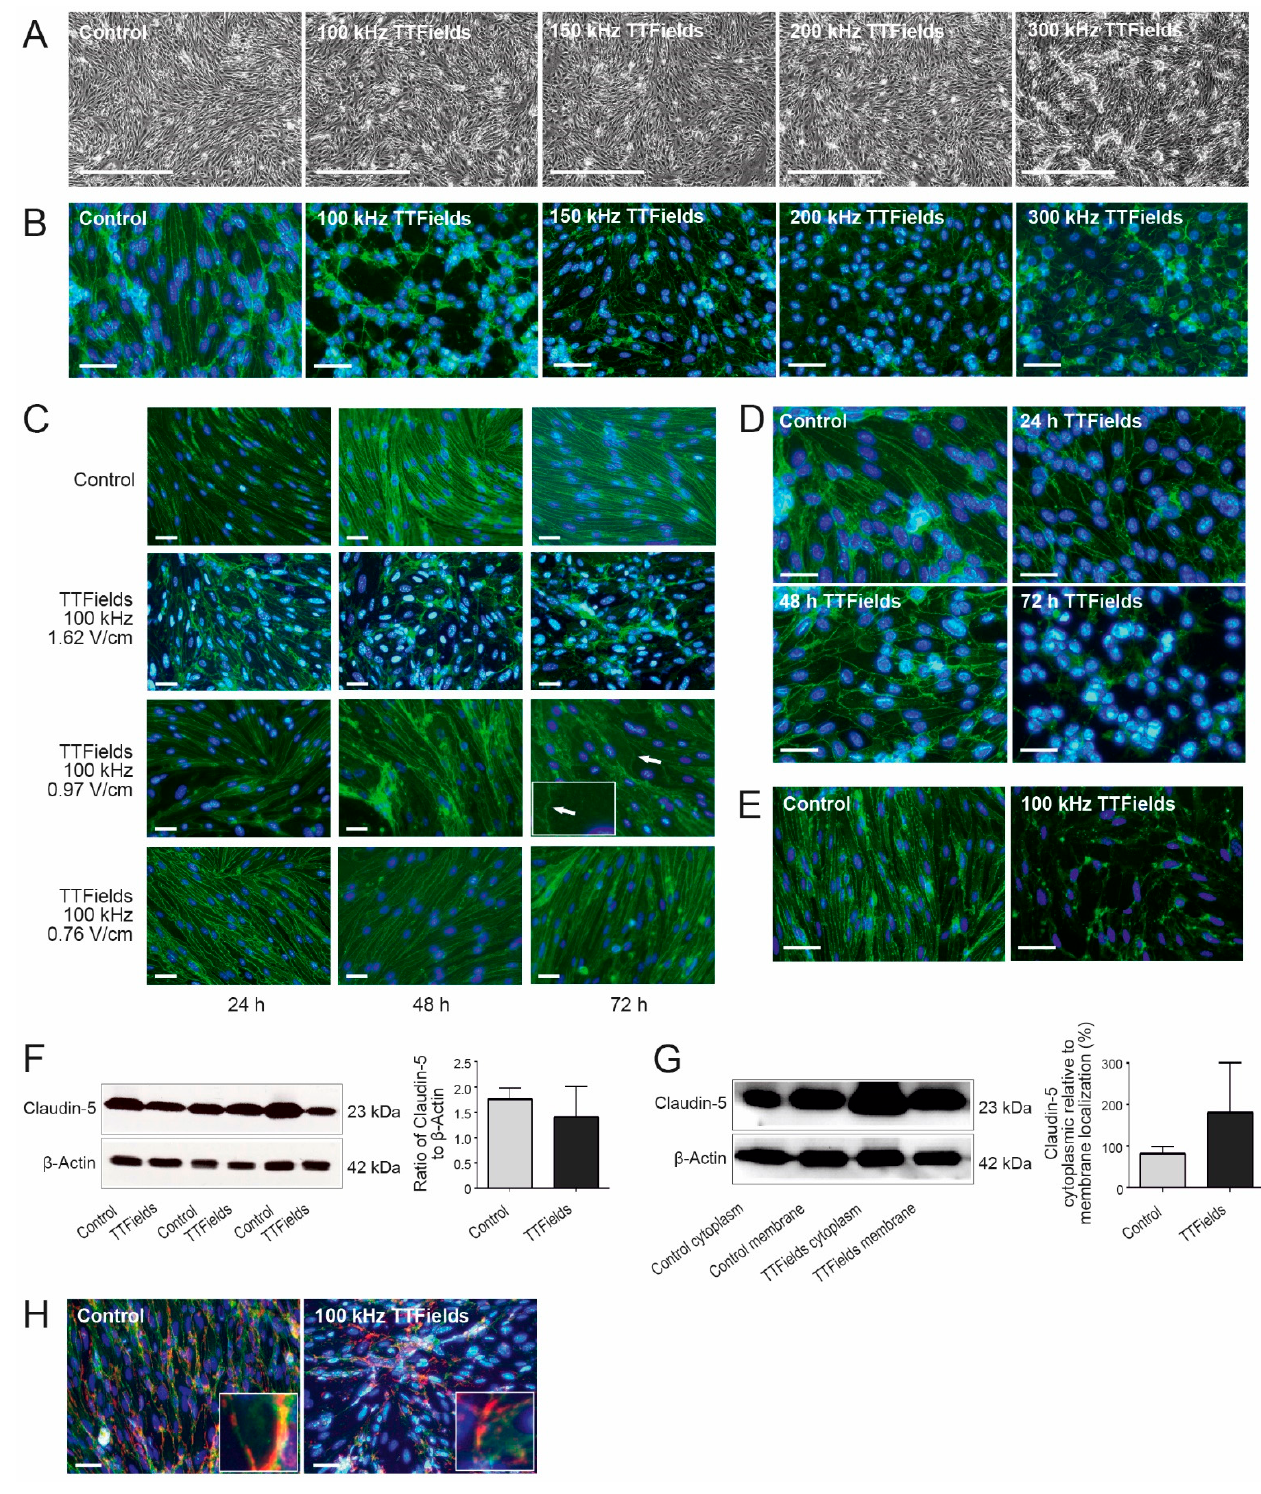
Figure 1. TTFields modified cerebEND structures by delocalizing claudin-5 and ZO-1 but not PECAM-1, with the strongest effects after at least 72 h: ( A ) light microscopy images of confluent monolayers of cerebEND cells untreated or treated with TTFields at 100–300 kHz for 72 h. Scale bar = 500 µ m. ( B ) Immunofluorescence staining of cells under the same treatment conditions with antibody against claudin-5 (green). ( C ) cerebEND cells treated with 100 kHz TTFields for 24–72 h at TTFields intensities of 1.62, 0.97, and 0.76 V/cm, respectively. The arrow points to a large cell with frayed outlines in